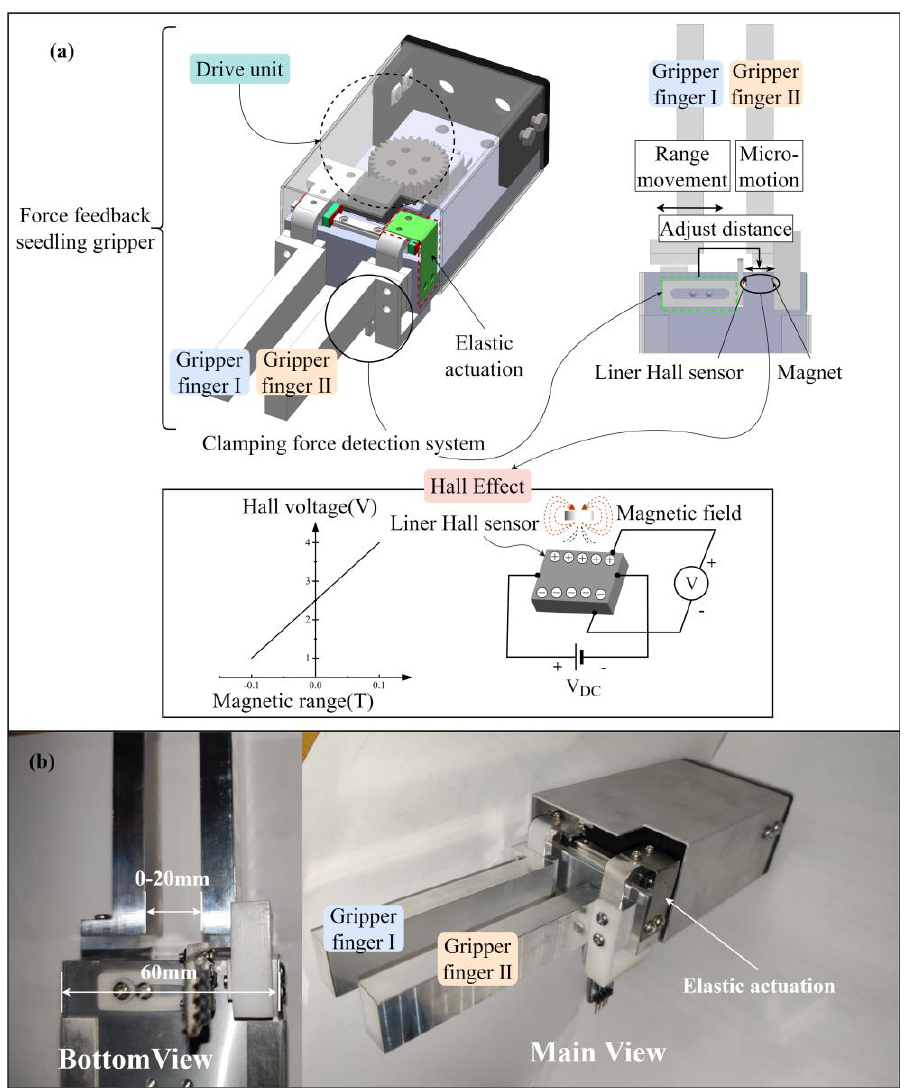
Figure 2. Force feedback seedling gripper structure: ( a ) schematic of the gripper; ( b ) physical view of the gripper.